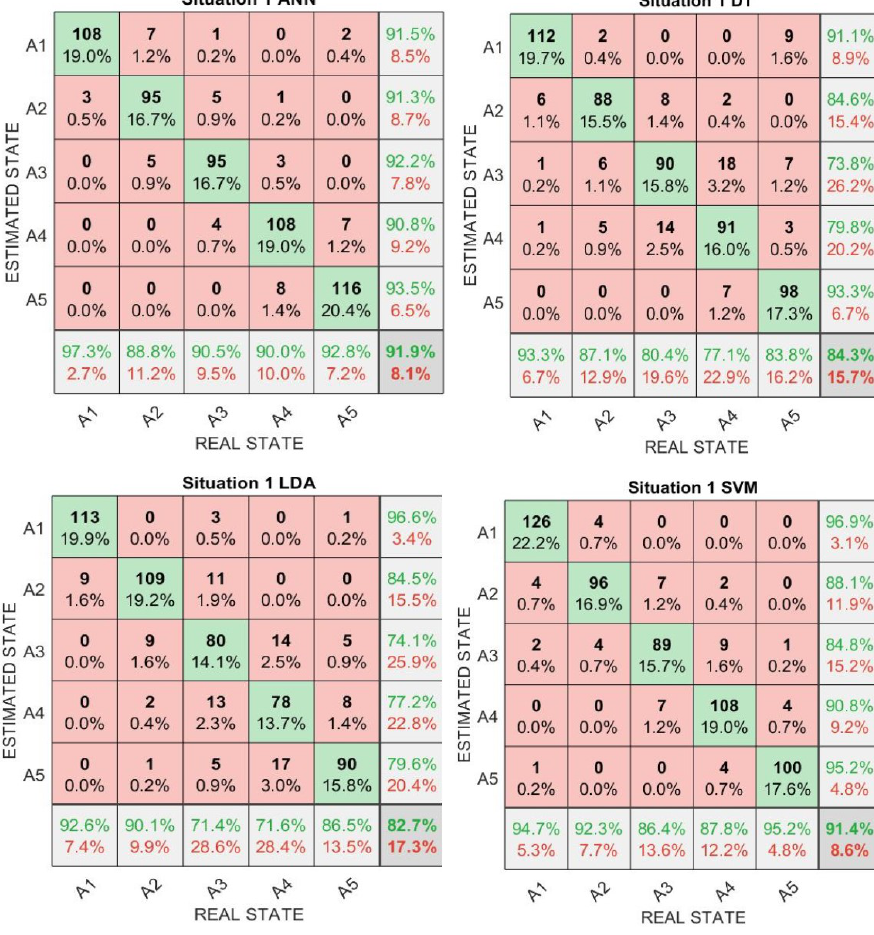
Figure A1. Situations 1 ANN, DT, LDA,